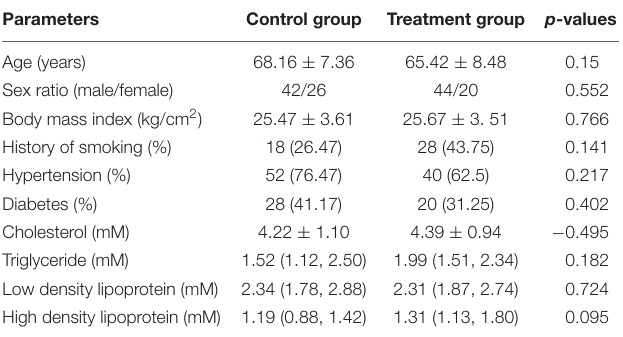
TABLE 1 | Comparison of baseline clinical characters.